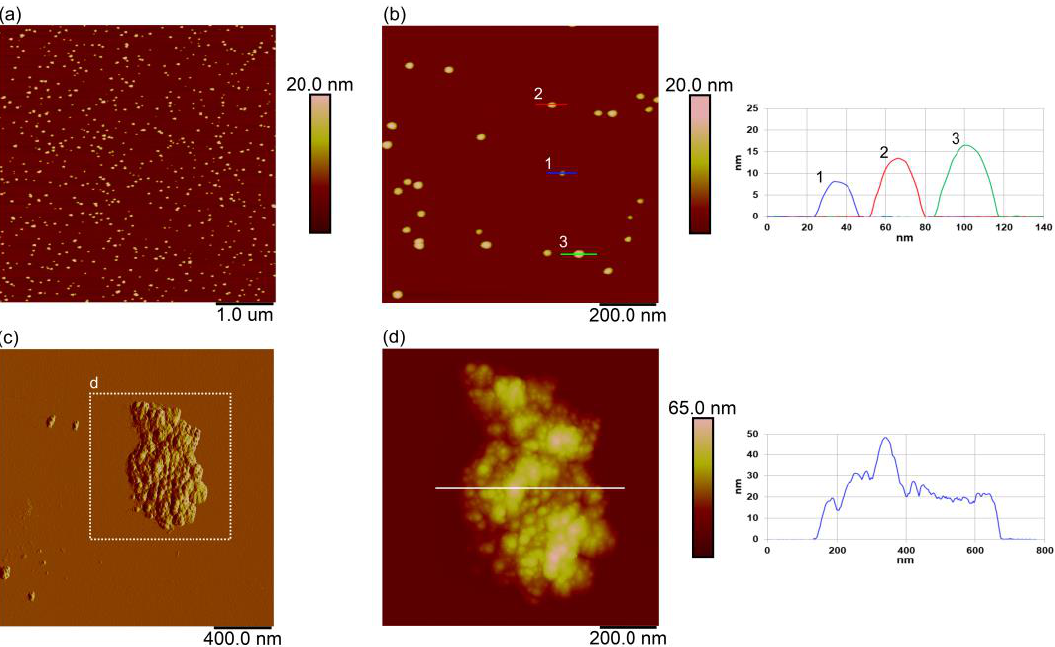
Figure 1. AFM characterization of SiO 2 nanoparticles (10 µg mL −1 ) in ultrapure water ( a , b ) and in filtered natural seawater ( c , d ). Images are acquired using tapping mode in air and presented as height ( a , b , d ) and amplitude data ( c ), with scan sizes: 5 µm × 5 µm ( a ); 1 µm × 1 µm ( b ); 2 µm × 2 µm ( c ); 1 µm × 1 µm ( d ) with vertical profiles along indicated lines showing particle heights. Line crossing nanoparticle and belonging vertical profile along indicated line in (b) are shown in the same color and indicated by the same number.